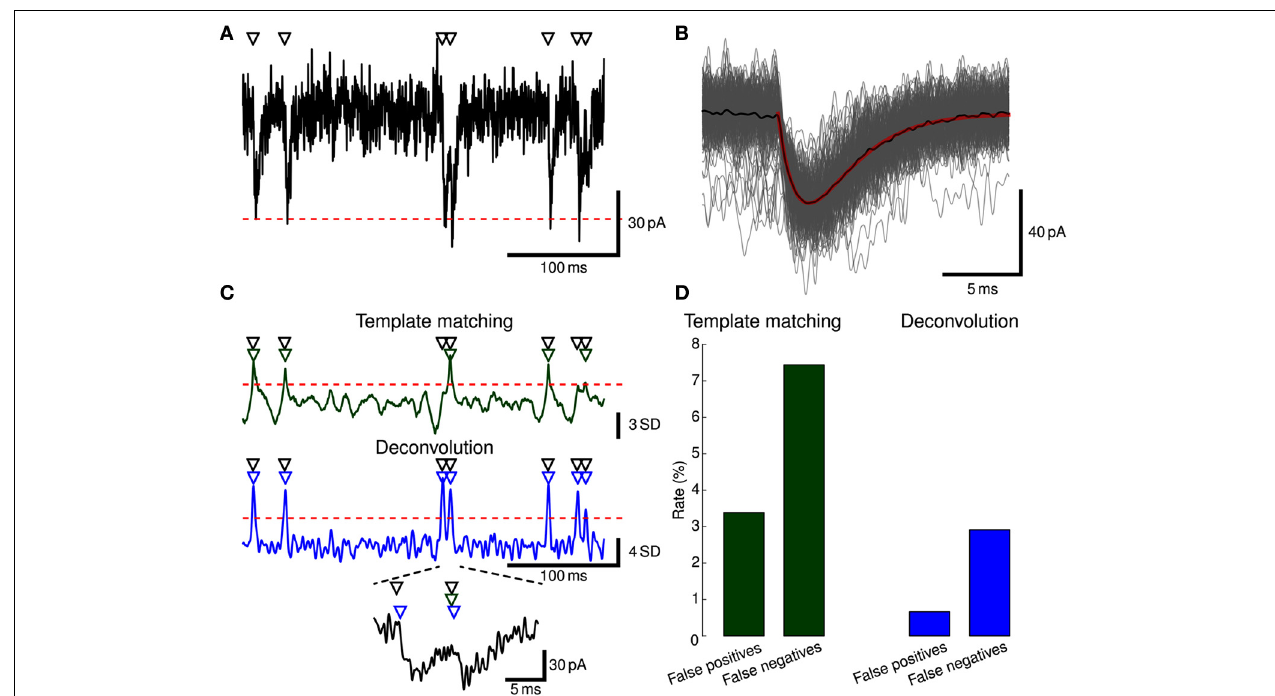
FIGURE 5 | Event detection. (A) EPSCs were simulated in a ball-and-stick modelwithNEURON.Onsettimesofsynapticconductancechanges(triangles attop)weresimulatedasaPoissonprocesstoyieldameanEPSCfrequencyof 5Hz. Colored noise was added as low-pass filtered white noise ( f c = 1 . 0kHz). Reddashedlineindicatesmean − 5SD.Onlyasubsetofthefullsimulation(60s duration) is shown. (B) To generate a template waveform, we first extracted data periods surrounding negative peaks below mean − 5 SD (gray traces). The peak-aligned average of these data periods (black trace) was then fitted to a bi-exponentialfunction(redtrace)servingasatemplate. (C) Detectioncriterion